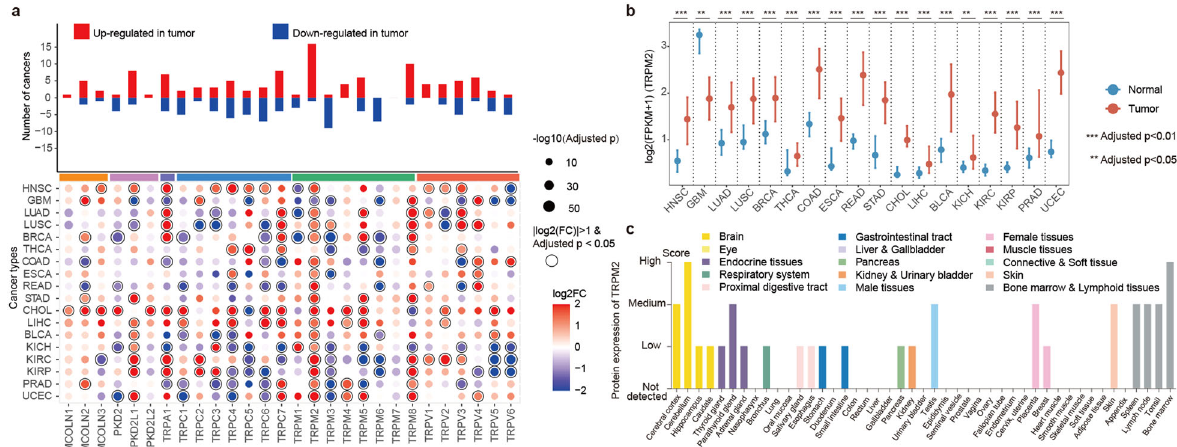
Fig. 2 Transcriptome dysregulation of TPR genes in cancer. a Bar plots showing the number of cancer types that each TRP gene exhibited upregulation or downregulation. The heat map at the bottom showing the fold-changes of TPRs in comparison between cancer and normal. b Box plots showing the expression of TRPM2 in cancer and normal samples across cancer types. Centre line is the median, bounds of box are the upper and lower quartile. ***adjusted p < 0.01, **adjusted p < 0.05. c Bar plots showing the expression of TRPM2 protein across normal tissues. Tissues were colored by the